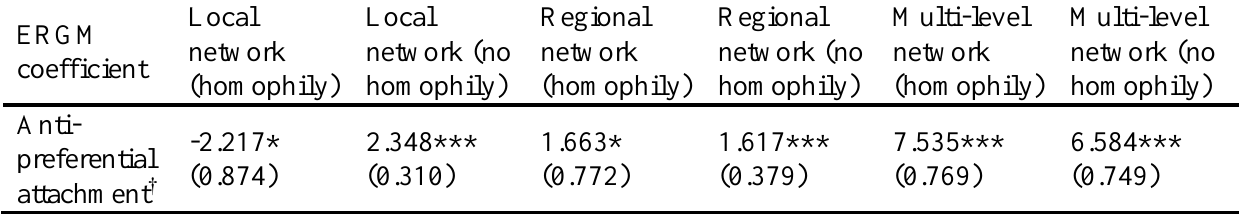
Table A1.4: Model results illustrating the interplay between within-country homophily and anti-preferential attachment for the local, regional, and multi-level networks. Pendant nodes were not included in any of the